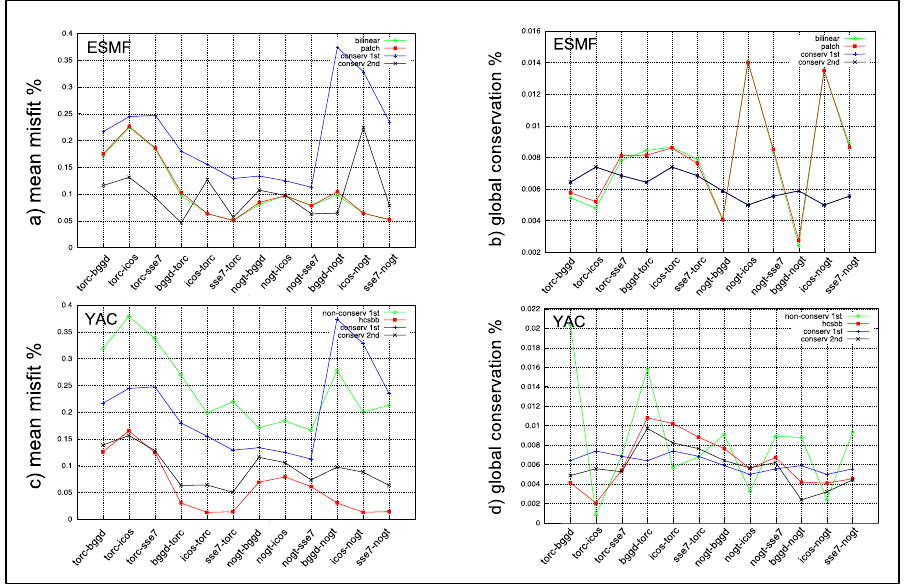
Figure 19. Mean misfit (%) for the different regridding algorithms in ( a ) ESMF and ( c ) YAC; source global conservation (%) for the different regridding algorithms in ( b ) ESMF and ( d ) YAC.